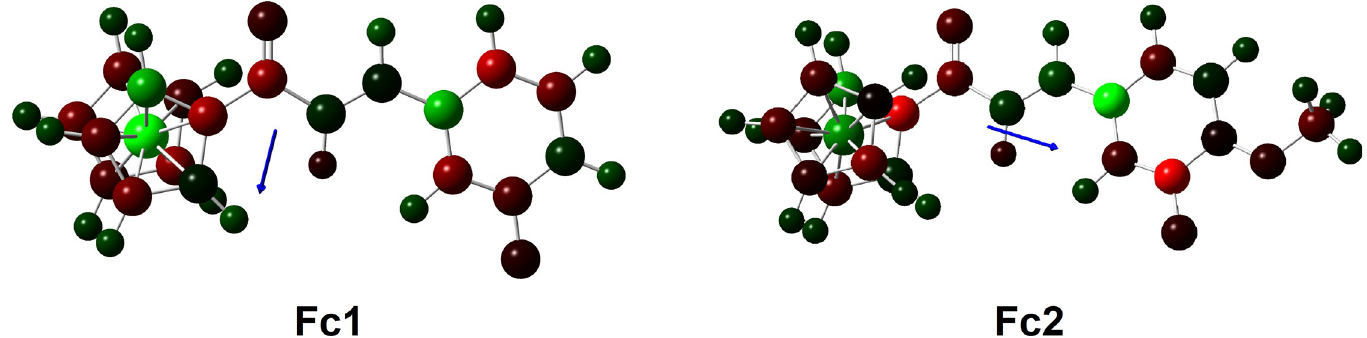
Fig 11. Dipole moment vector for Fc1 and Fc2 at B3LYP/6-311G++(d,p) level of theory.